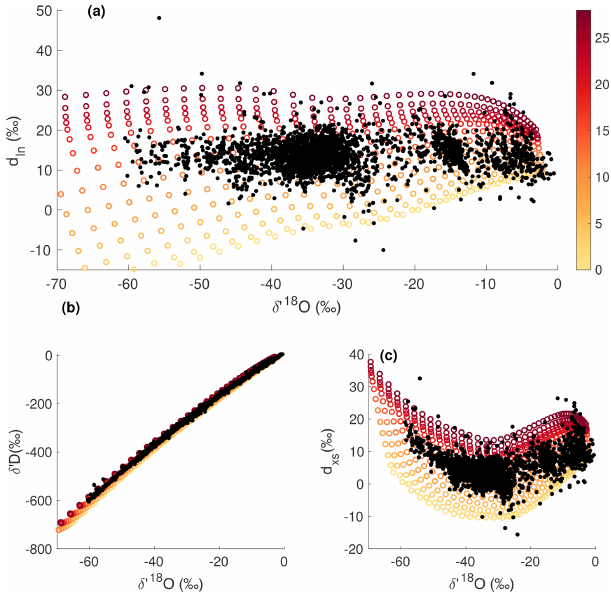
Figure A12. Tuning SWIM with linear supersaturation parameter- ization. (a) The modeled δ 18 O and d ln of precipitation (colored circles) for a range of condensation and evaporation temperatures. Color shading shows source region evaporation temperature in de- grees Celsius ( ◦ C). Black dots are the target dataset as described in the text. Modeled results are for the optimized supersaturation parameterization ( S i = 1 − b × T , b = 0 . 00525 ◦ C − 1 ) using the lo- cal closure assumption and the NCEP/NCAR reanalysis dataset for source region correlations. (b) Same as panel (a) for the modeled and target δ 18 O and δ D of precipitation. (c) Same as panel (a) for the modeled and target δ 18 O and d xs of precipitation.